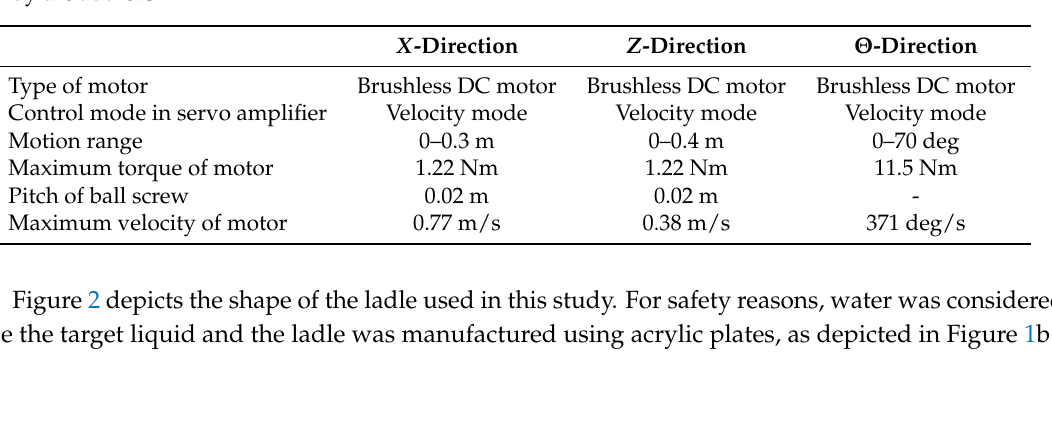
Figure 1. Photos of tilting-ladle-type automatic pouring machines. ( a ) An automatic pouring machine that is actually applied in a casting plant, and ( b ) the automatic pouring machine that has been developed in the present laboratory of the authors. Table 1. Specifications of drive systems in the tilting-ladle-type automatic pouring machine developed by the